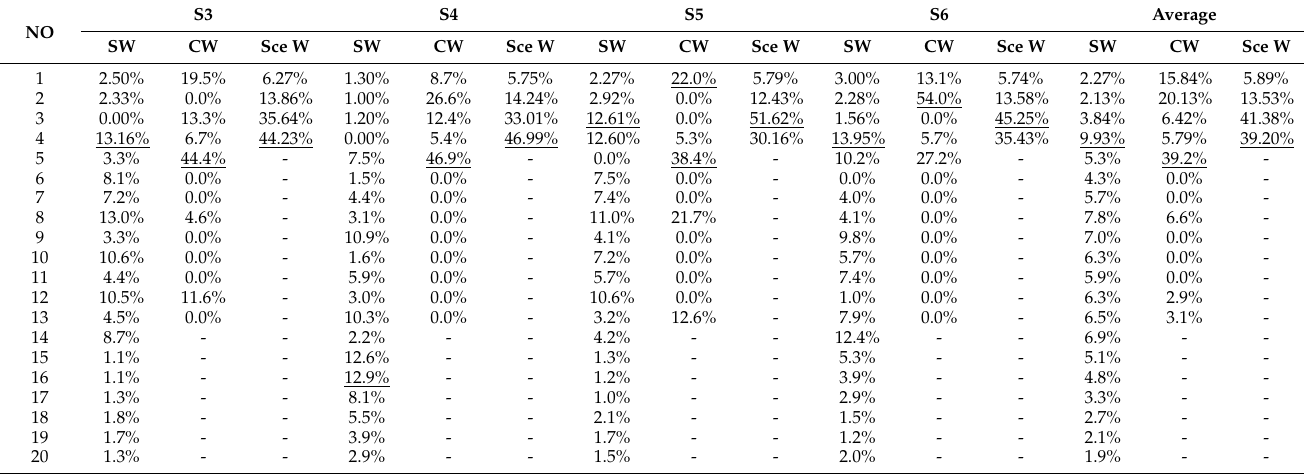
Table A2. Results of pairwise comparison of the Saaty scale (from − 9 to 9) for the Central Java